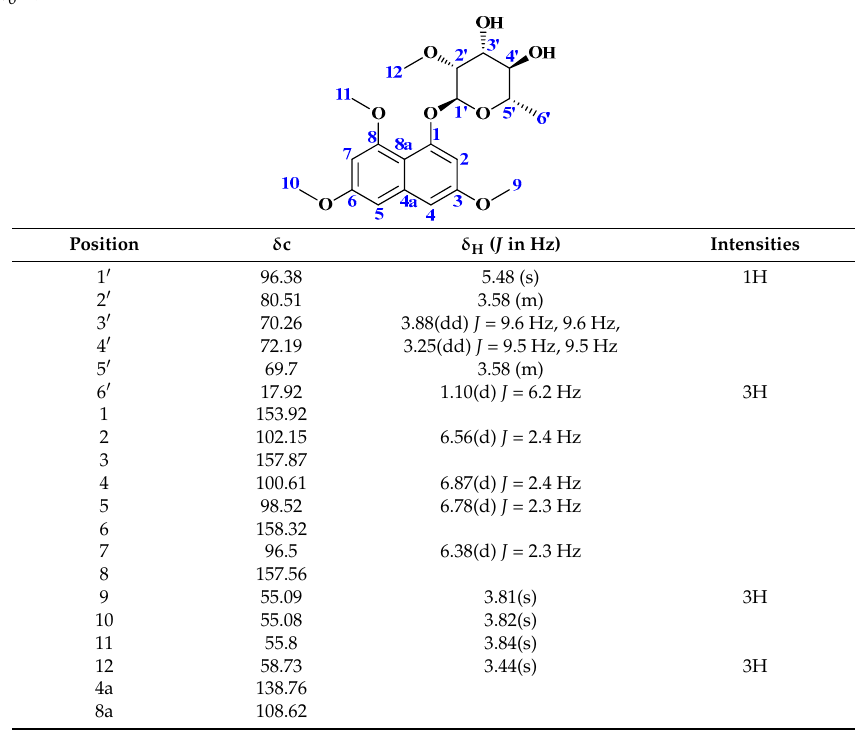
Table 1. 1 H NMR and 13 C NMR spectroscopic data (700 MHz) of compound IBR-3 measured in DMSO- d 6 a .